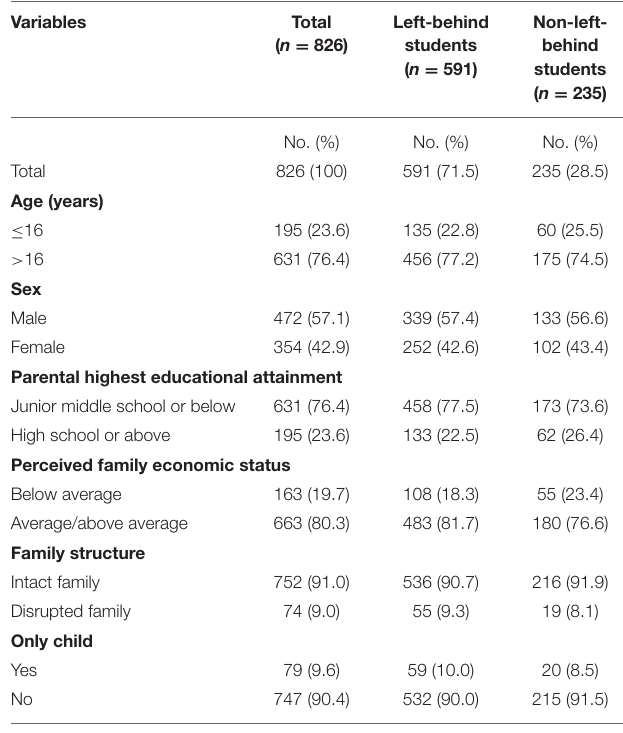
TABLE 1 | The demographic characteristics of the left-behind students and non-left-behind students (N = 826). Variables Total ( n =